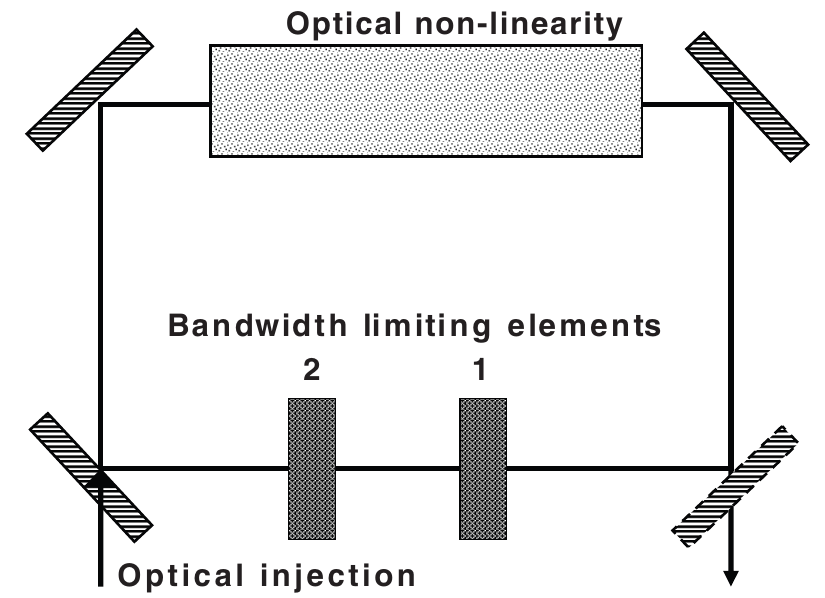
Figure 1. Schematic representation of the considered